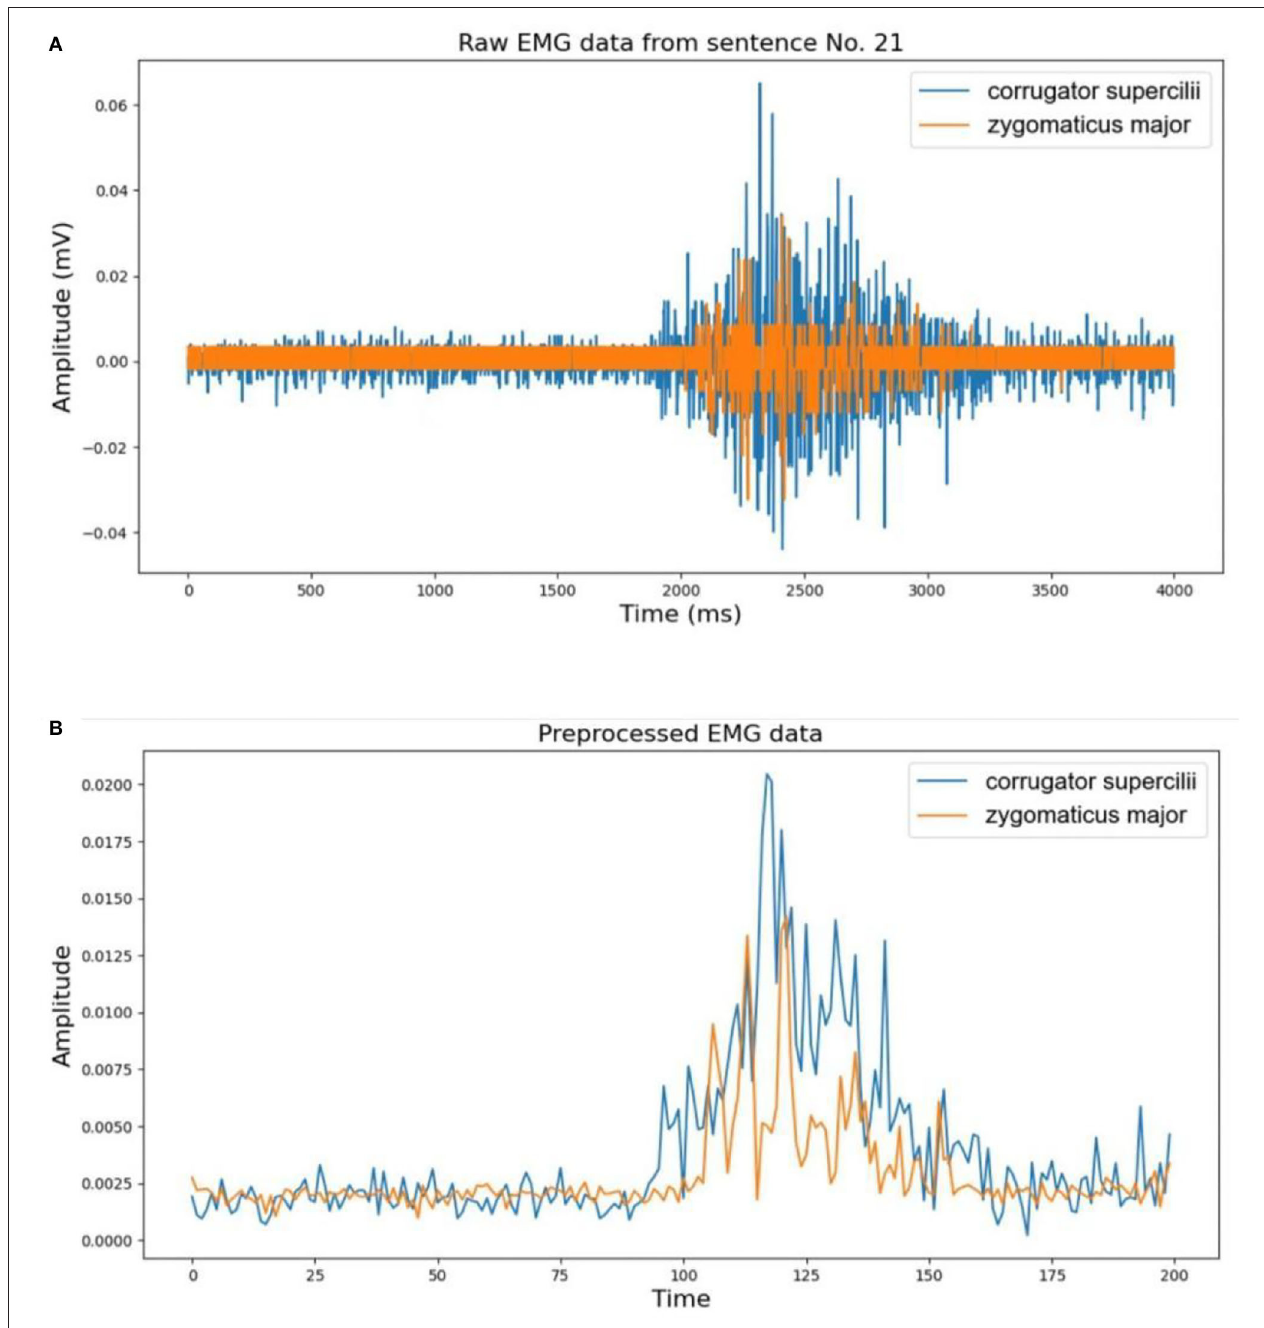
FIGURE 3 | An example of electromyography (EMG) data preprocessing: (A) raw EMG data from sentence no. 21; (B) corresponding preprocessed EMG data.